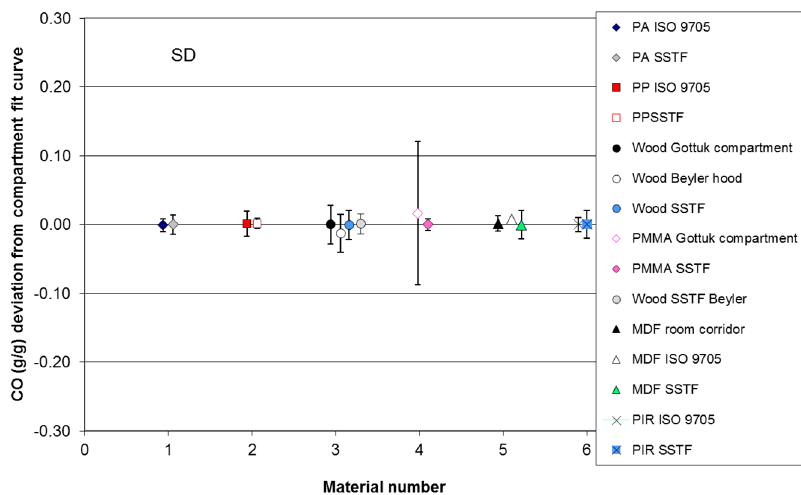
Figure 5. Means and standard deviations of deviations from trend lines for compartment fire CO yields and from compartment fire trend lines for SSTF CO yields.